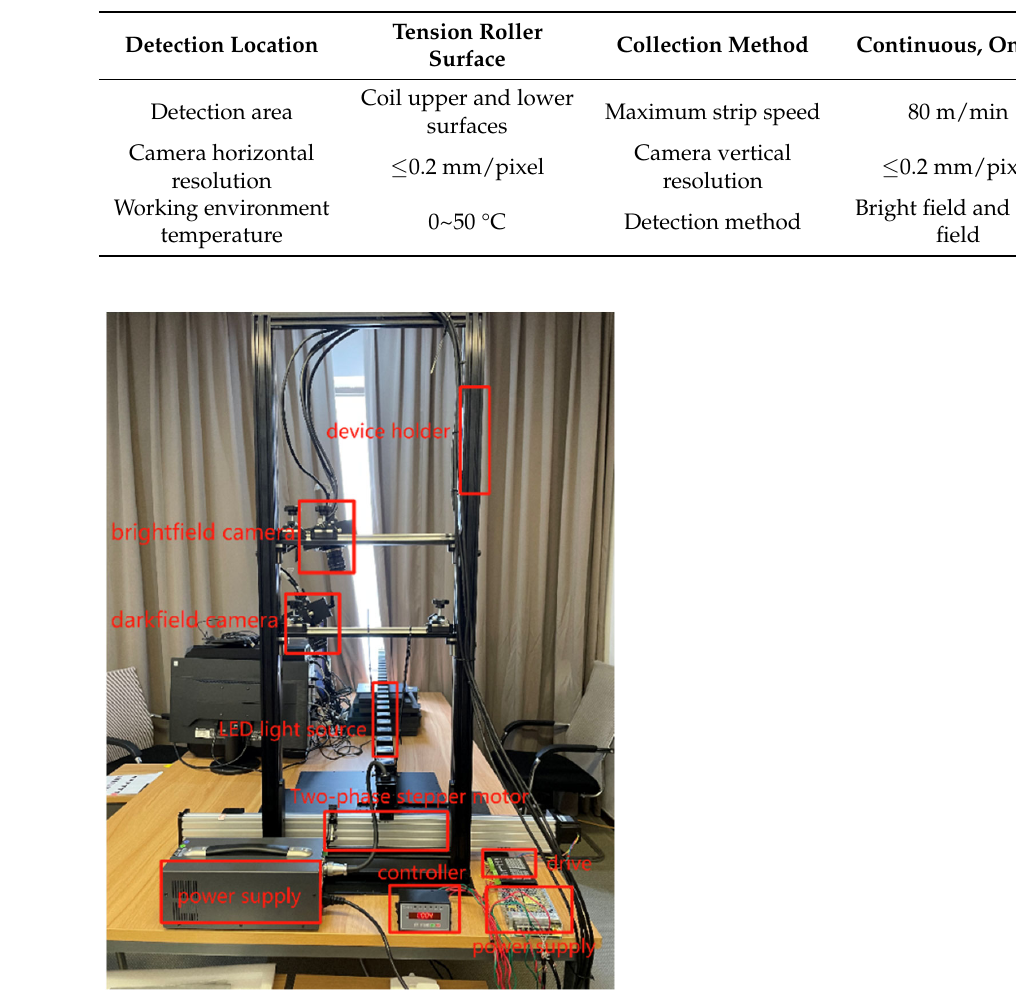
Table 3. Experimental process parameters.